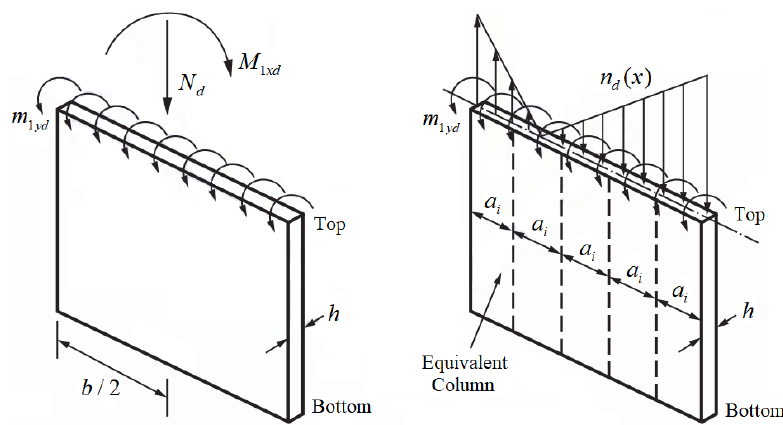
Figure 6. Brazilian code approximate procedure: wall discretization [2], [3]